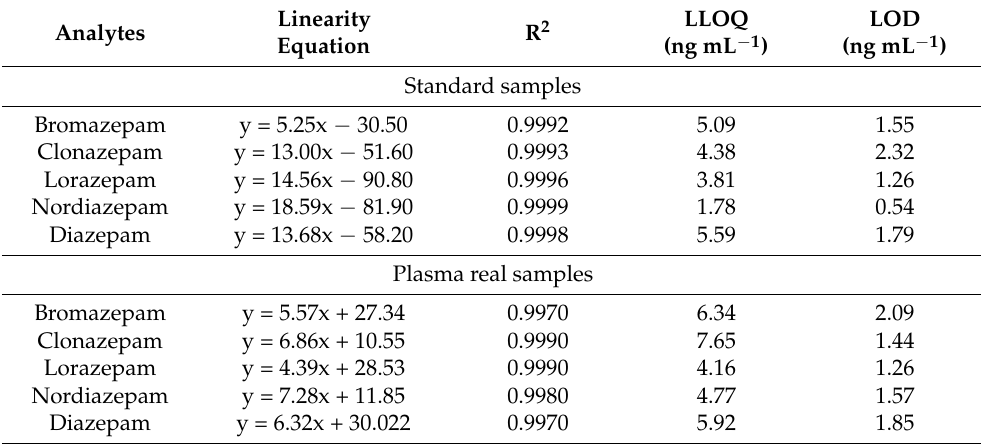
Table 1. Linearity and sensitivity data for the proposed method (x = ng mL − 1 , n = 3) in standard and real